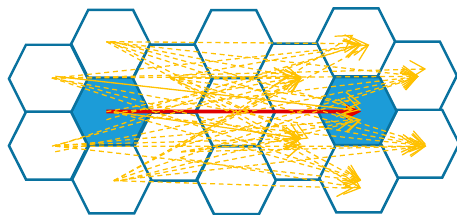
Figure 3. The contiguity-based spatial weight of flows.